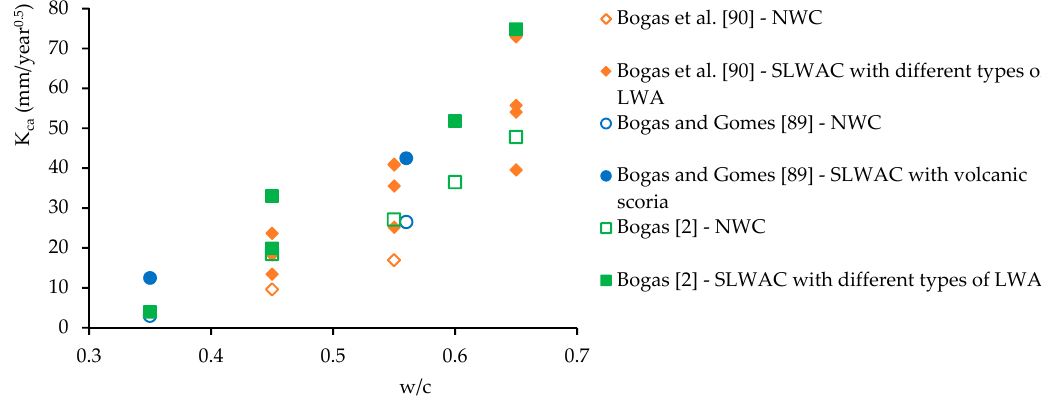
Figure 6. Carbonation coefficient vs w/c, according to various authors [2,89,90] .